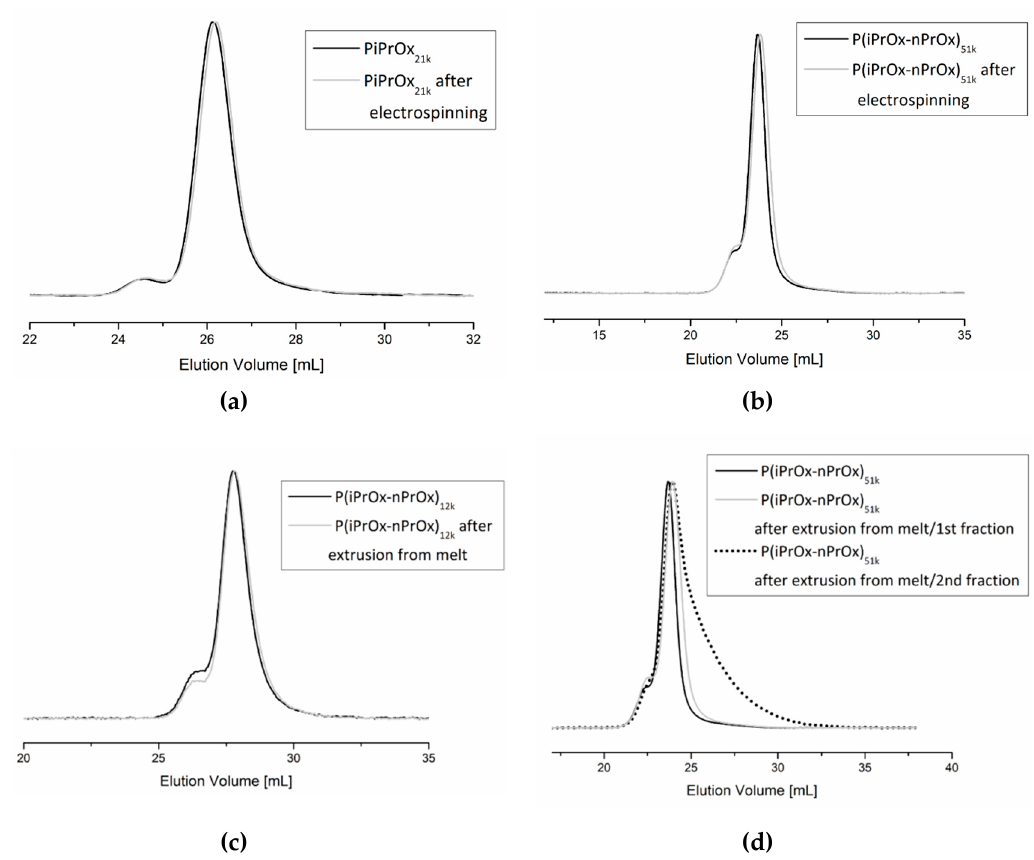
Figure 8. SEC traces of ( a ) PiPrOx 21k and ( b ) P(iPrOx–nPrOx) 51k before and after electrospinning and of ( c ) P(iPrOx–nPrOx) 12k and ( d ) P(iPrOx–nPrOx) 51k before and after extrusion from melt.